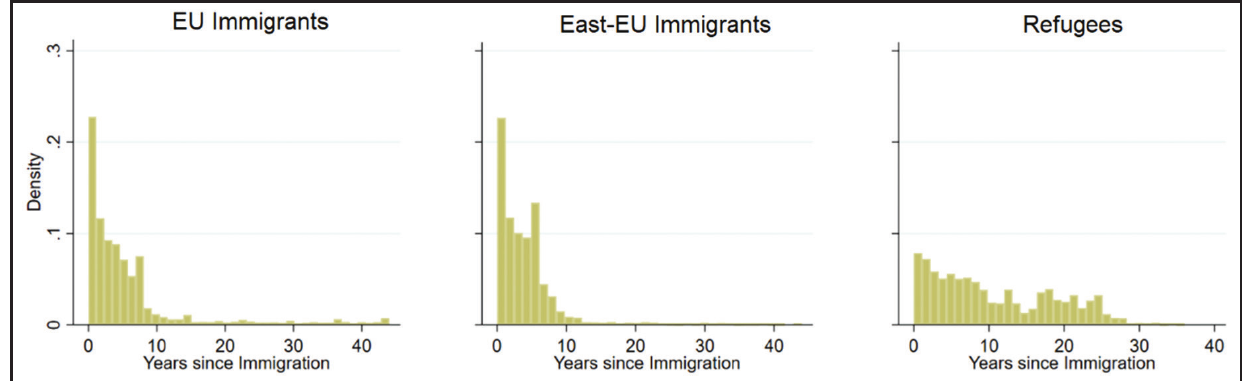
Figure W13 Distributions of years since immigration at the entry year into the subsidized sector, with entry defined as going from 0 to 1 months of wage